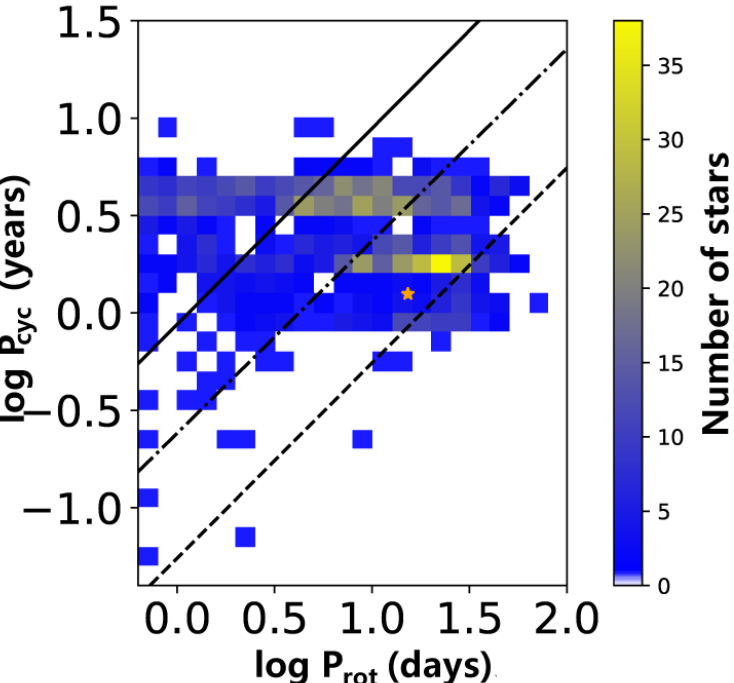
Figure 17. Rotation period P rot vs. magnetic activity cycle period P cyc of 1189 Kepler targets. Note that false cycles remain in our results from applying our smoothness metric. The solid line is the active sequence, the dash-dotted line is the inactive sequence, and the dashed line is the short-cycle sequence as defined by Ferreira Lopes et al. [51]. The color represents the number of stars. The orange star marker is KIC